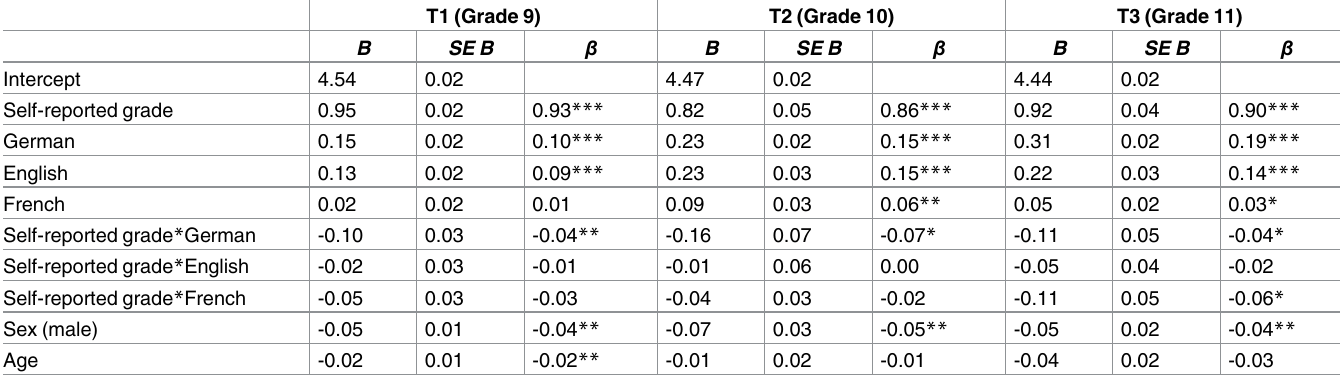
Table 2. Summaryof moderation analyses for variables predicting actual grades (N T1 = 3431; N T2 = 2427; N T3 =